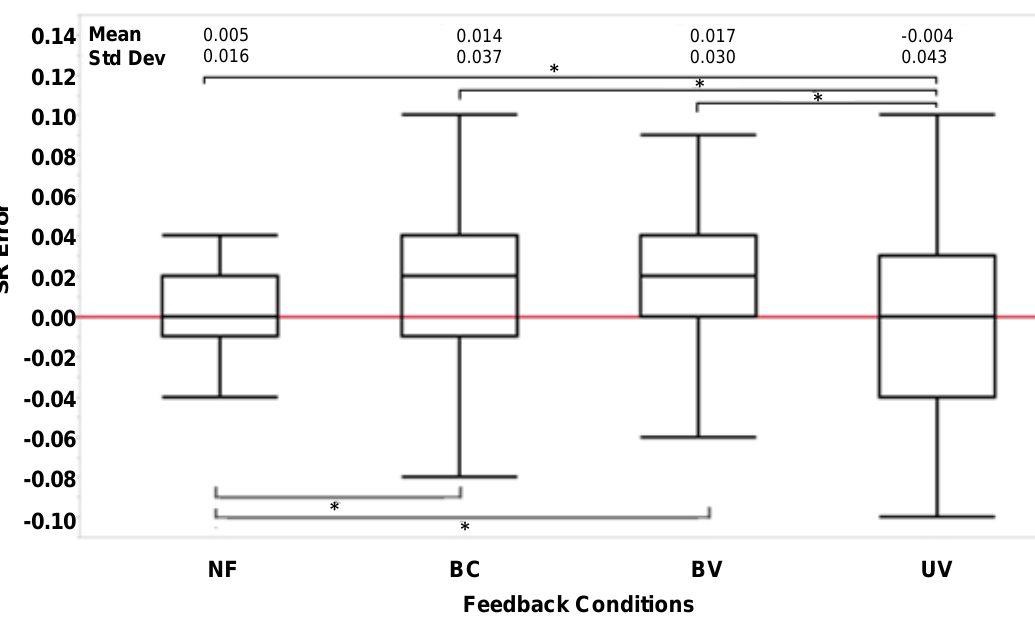
Figure 6: SR Error. Mean SR error values across feedback (BC, BV, UV) and no feedback (NF) conditions. BC: Bidirectional control – constant vibration; BV: Bidirectional control – variable vibration; UV: Unidirectional control – variable vibration. Statistically significant differences were found between NF and feedback conditions (BC, BV, and UV), including between feedback strategies UV-BC and UV-BV, but not between BC – BV strategies. Statistically significant differences are denoted with an ‘*’. Mean and standard deviations (Std Dev) are listed above.